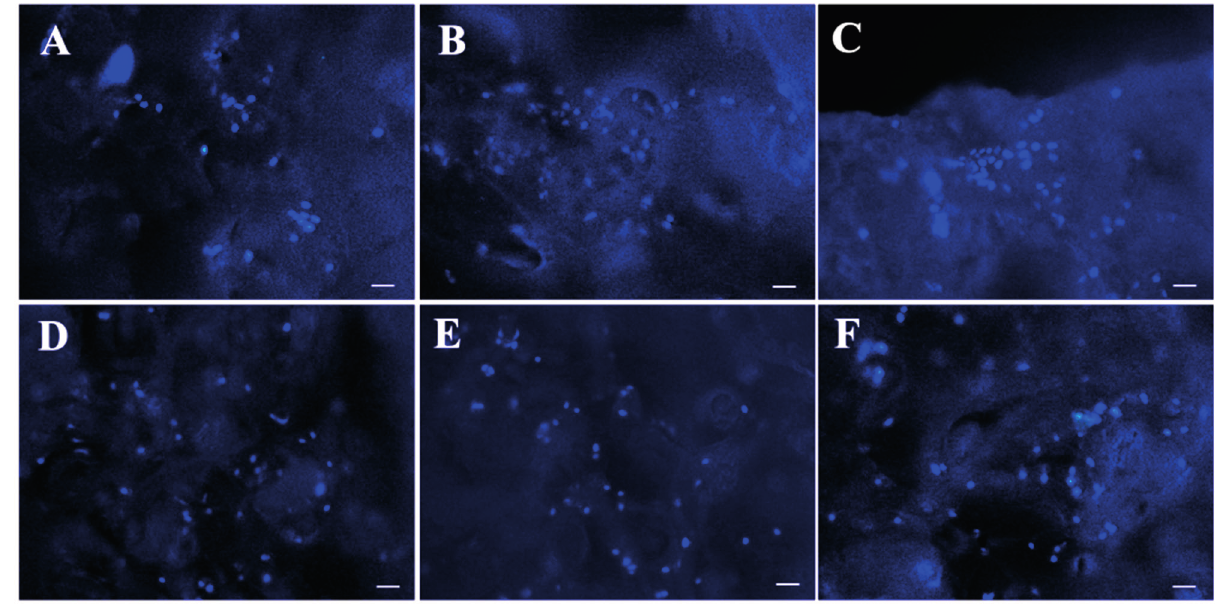
Figure 8. DAPI nucleus staining showing the attachment of HDF after 24 h ( A – C ) and 48 h ( D – F ) on ( A , D ) Chitin, ( B , E ) Chitin/PBS, and ( C , F ) Chitin/PBS/CSnps. Scale bar denotes 50 μ